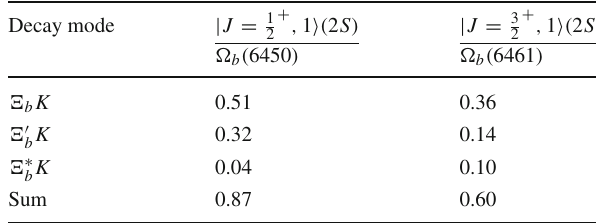
Table 5 Partial decay widths (MeV) for the 2 S -wave (cid:2) b states, whose masses (MeV) are taken the quark model predictions of Ref. [13] Decay mode